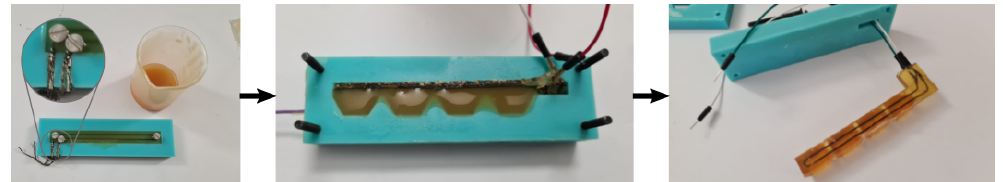
Figure 5. Moulding the sensor and finger. The mould for the sensorized finger has three bolts around which the sensor fibre is wrapped, and cutouts to keep the crimp connectors in place. The fibre is fixed, and the liquid polymer mixture is poured over it. After curing, the sensor is placed in the finger mould before the finger is cast. When the finger has cured, it can be demoulded and